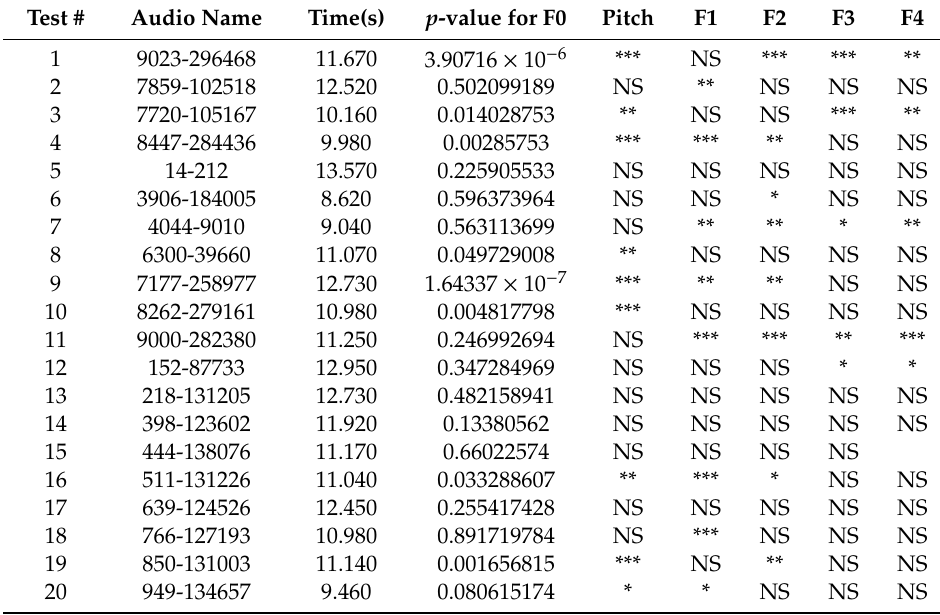
Table 10. The results obtained after applying the proposed method to the dataset LibriSpeech.